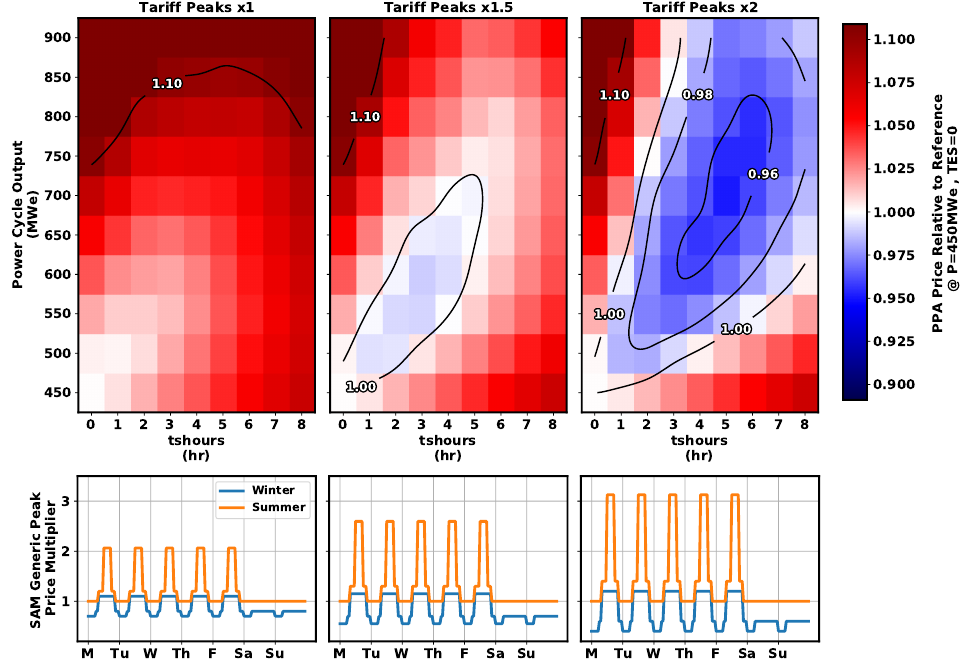
Figure 10. Effect of increased price ramping on final PPA price. Each column represents PPA price results for the SAM generic tariff rates with increasing peak-amplification from left to right. Heatmaps show PPA prices relative to the reference design at 450 MW e and 0 h of storage for each market scenario. Contours are generated using interpolated data to highlight key regions: values higher than 1 perform worse than the reference; values lower than 1 perform better. Values higher than 1.1 are not shown for clarity. Corresponding tariff rates shown in bottom row for each